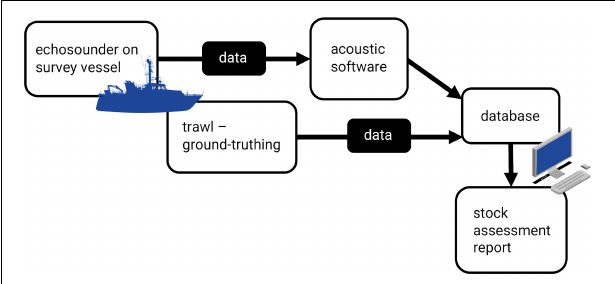
FIGURE 1 | Acoustic stock assessment workflow, from data collection with an echosounder and ground-truthing with trawl data to data processing and report